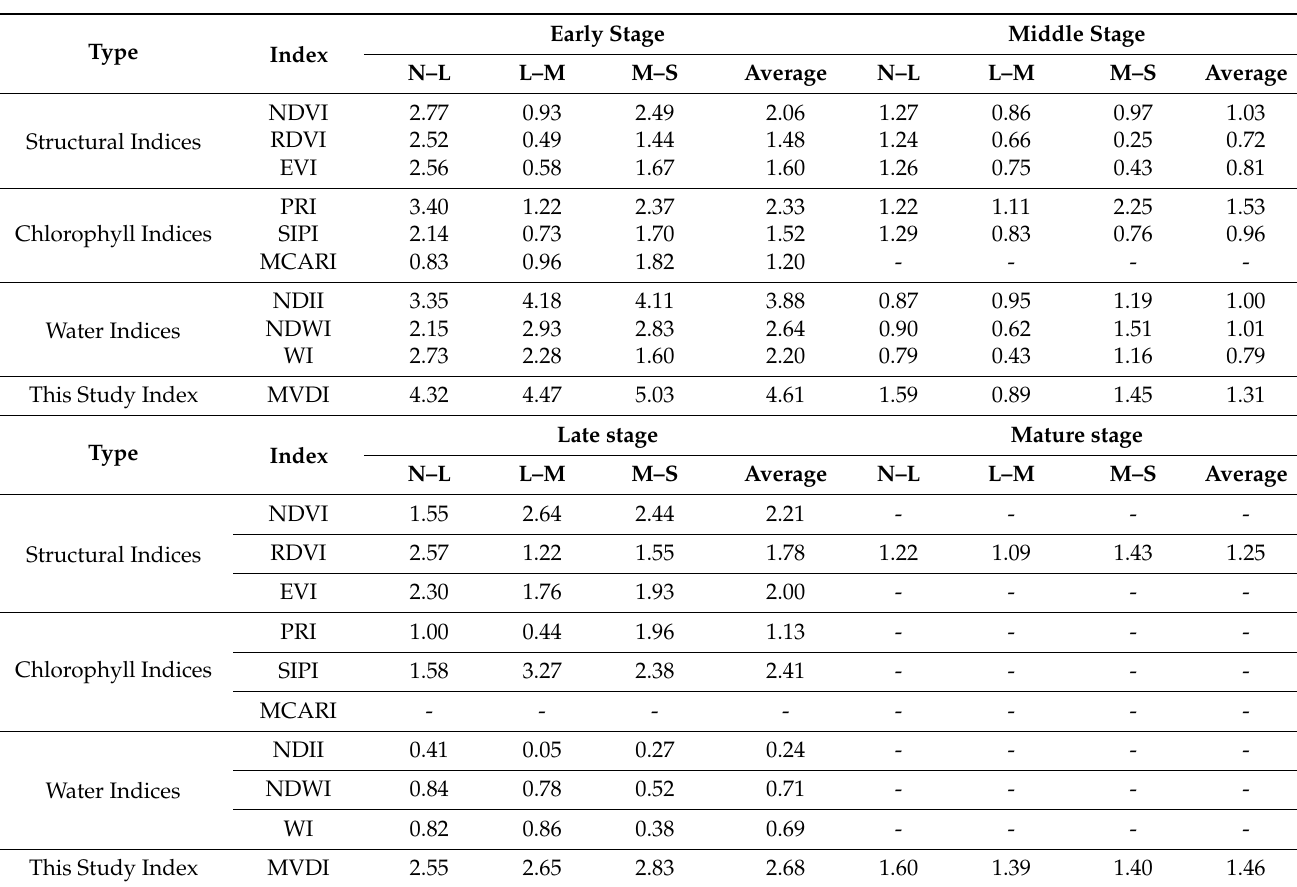
Table 4. The normalized mean distance between different water stress levels during the main growth stages of the crop (empty cell indicates that the index could not distinguish different water stress